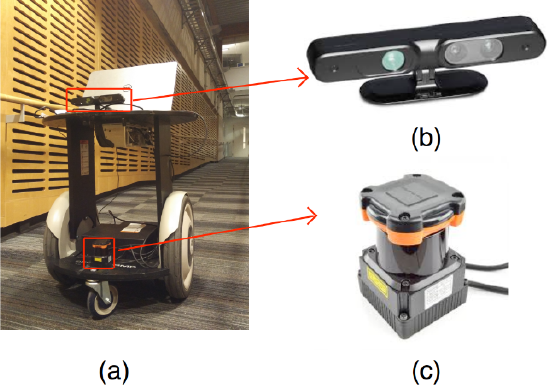
Figure 10. Robot hardware platform. ( a ) The Segway robot platform; ( b ) the Xtion RGB-D camera; ( c ) Hokuyo laser range finder.